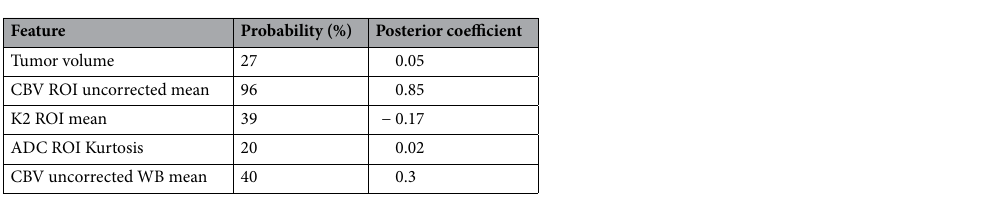
Table 2. Bayesian survival